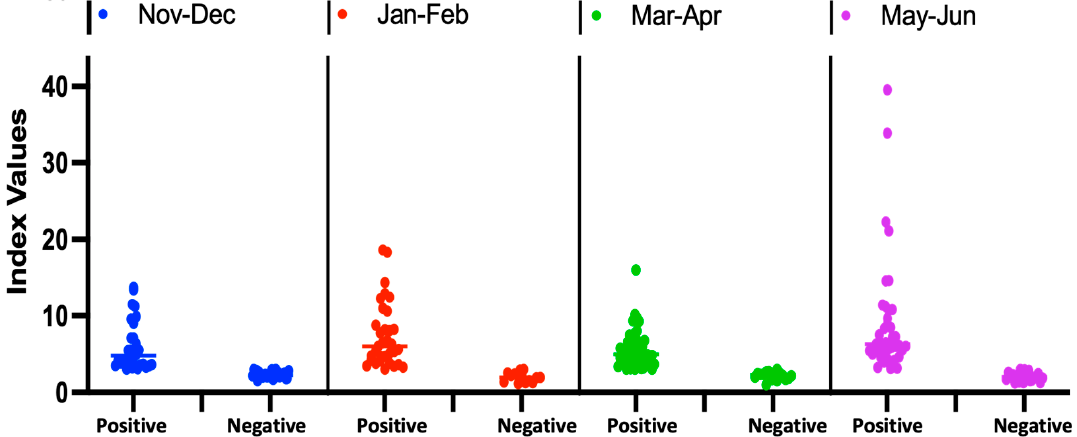
Figure 4. Level of SARS-CoV-2 spike protein IgG in Mali over time.